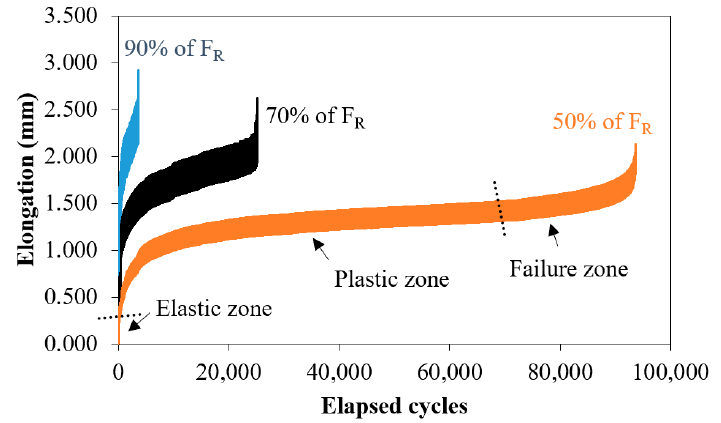
Figure 4. Typical elongations for the 1 wt% TiO2 / UHMWPE samples subjected to 90%, 70%, and 50% of F R .